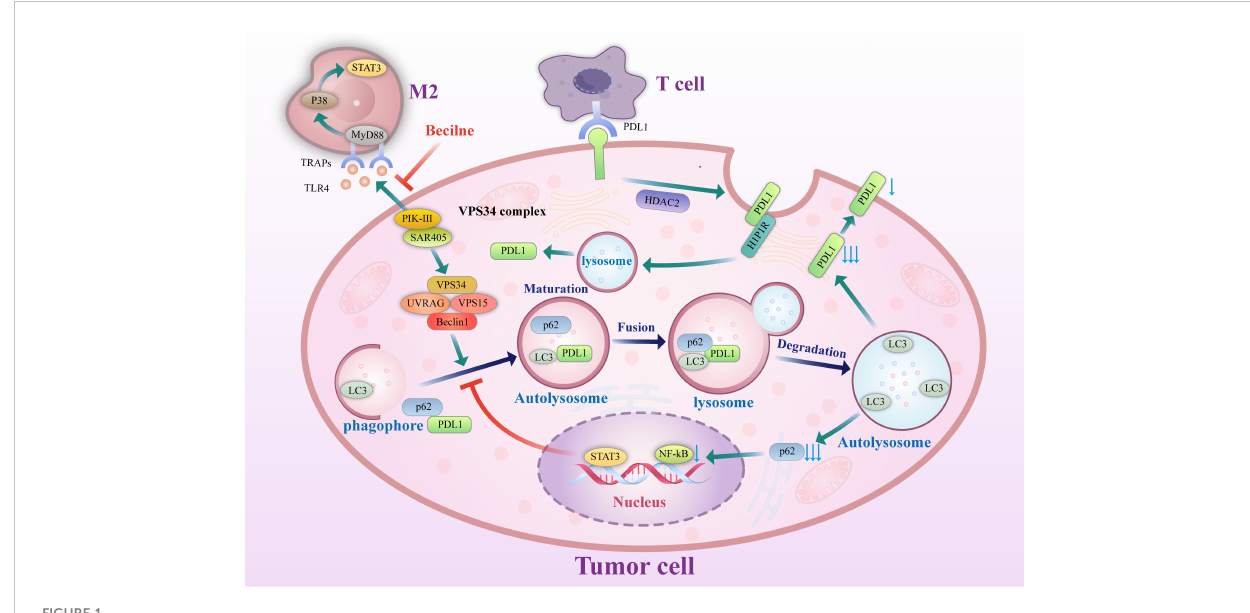
FIGURE 1 Autophagy and cancer cell immune